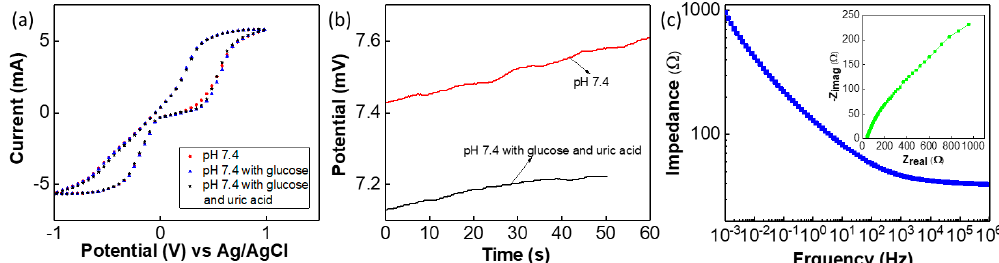
Figure 7. ( a ) CV analysis for pH 7.4, pH 7.4 with glucose and pH 7.4 with glucose and uric acid. ( b ) Open circuit potential (OCP) of the sensor in pH 7.4 and pH 7.4 with glucose and uric acid-based solution. ( c ) Impedance plot of the sensors (both SE and RE on cloth) at pH 7.4 based solution and inset shows the Nyquist plot.